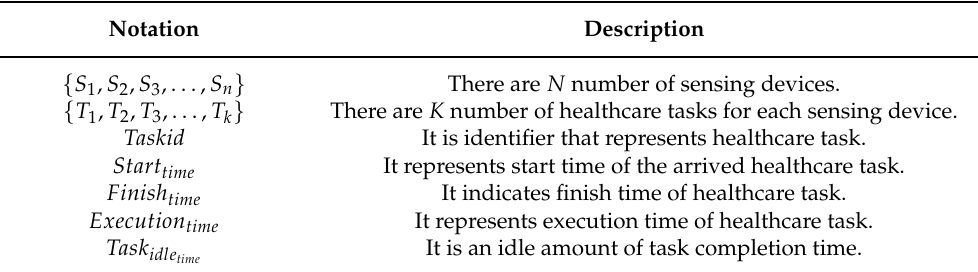
Table 4. Notations used in optimization problem